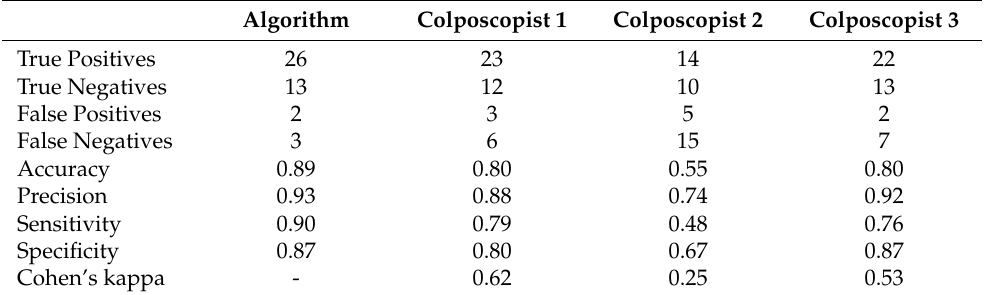
Table 3. Algorithm and colposcopists’ classification results based on histologic